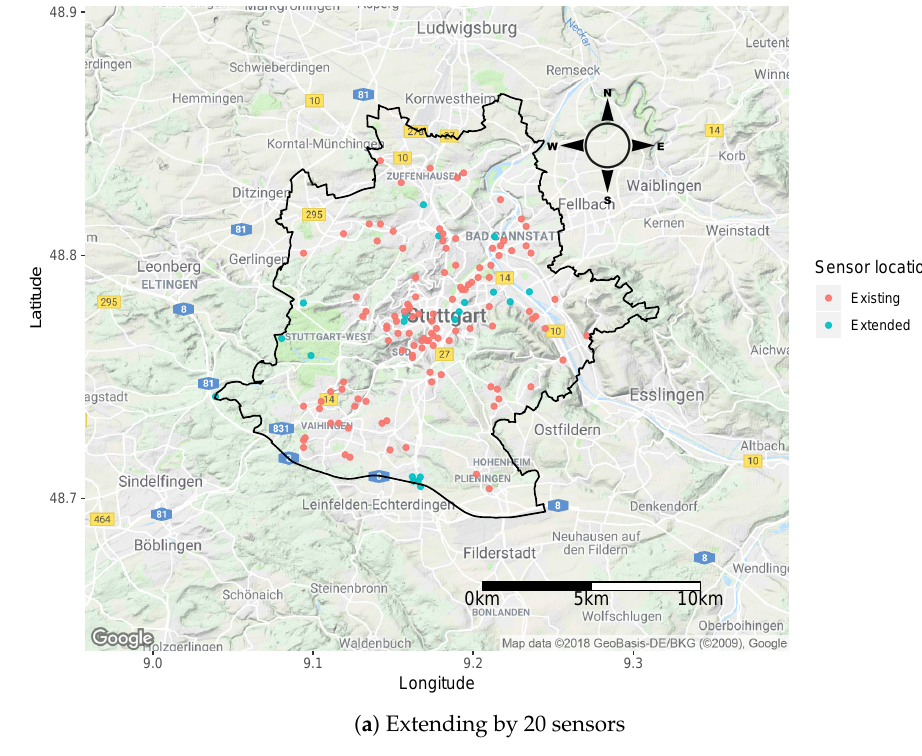
Figure 10. Diagnostic study to capture the impact of extending the number of monitoring sensors into the existing VGI based monitoring